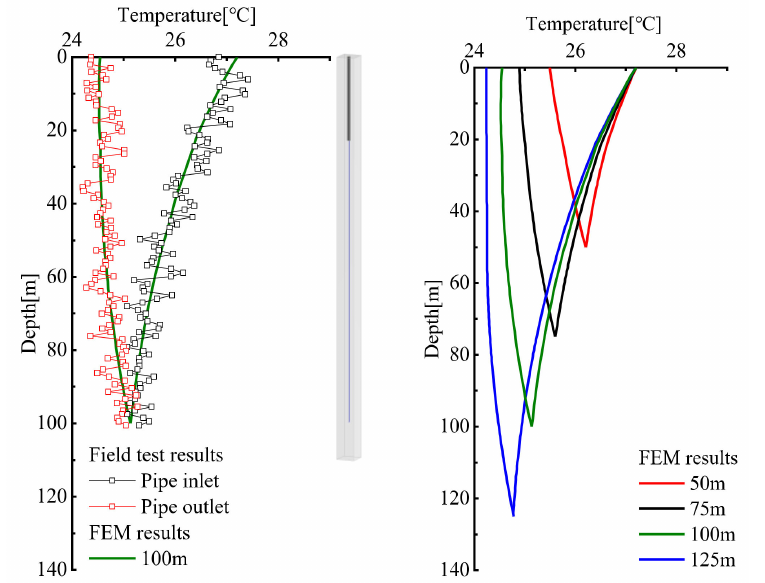
Figure 11. Temperature distribution of #1 pile heat exchange pipe along the depth direction (3.5 kW, 1.0 m 3 /h).